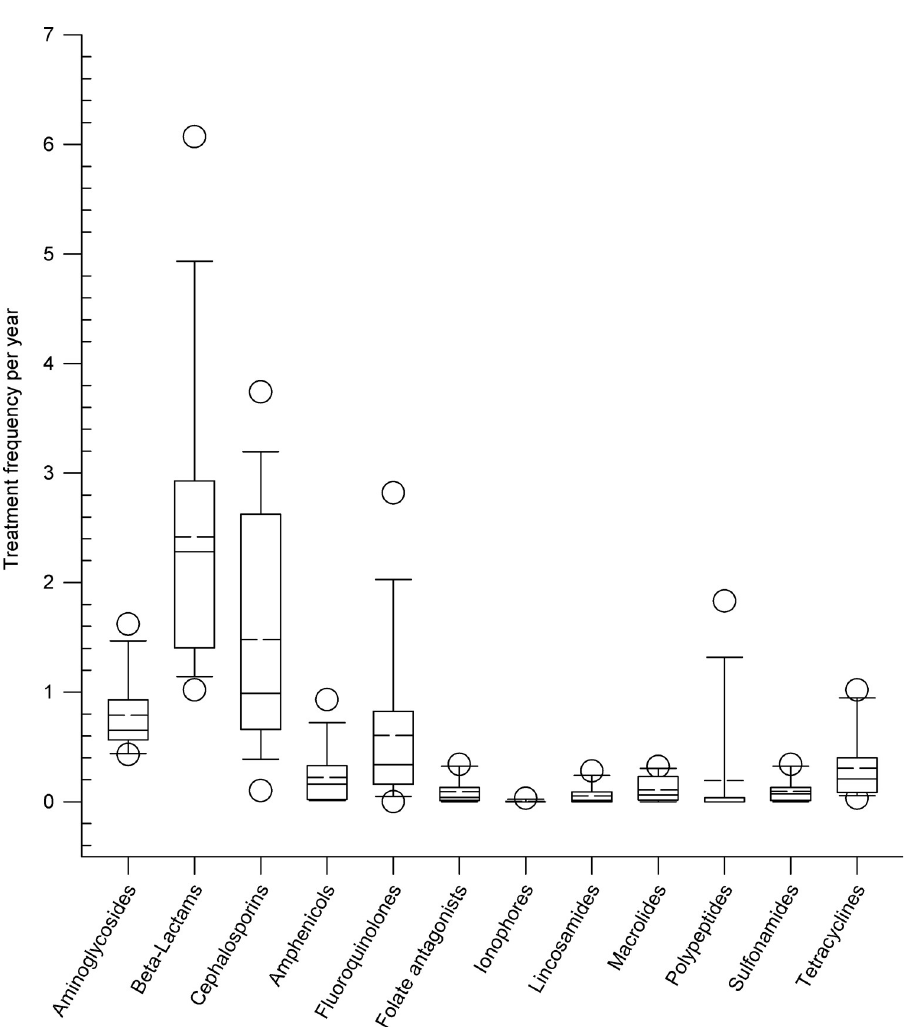
Fig 2. Treatment frequencies of different antimicrobial classes expressed per animal and year on nine dairy farms. Box, the range between the 1 st (Q1) and 3 rd (Q3) quartile; horizontal line, median; dashed line, mean; circles, outlying points (5 th , 95 th percentiles,